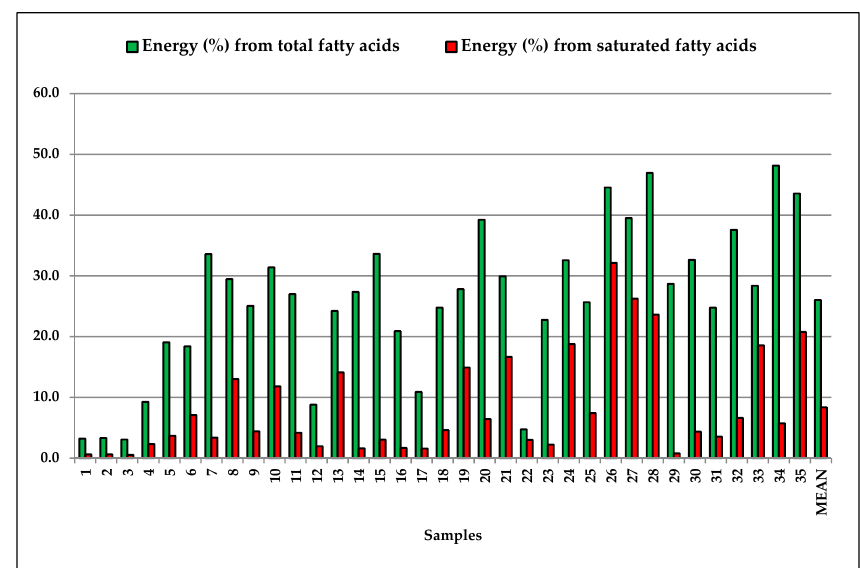
Figure 6. Energy (%) from lipids provided by 100 g of gluten-free samples.